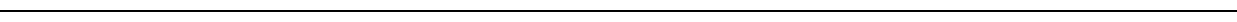
Fig. 2 Human MiPs engraft and are able to functionally regenerate dystrophic muscles. a , b Four weeks after delivery, immunostaining shows that fi broblast- and MAB-MiPs engraft and express hDYS to a similar extent in the heart, but differently in the hindlimb muscles ( gastrocnemius ). After AP20187 administration and at the end of treatment (eight weeks post delivery), the trend remains in vehicle-treated mice, whereas GFP and hDYS signals are ablated from AP20187-treated mice. Scale bars, ∼ 100 μ m; insets, 20× magni fi cation of indicated fi eld. c Tetanic force of EDL muscles and treadmill assay showed that skeletal muscle performance was increased in fi broblast-MiP-treated vs untreated mice, and increased in MAB-MiP- vs fi broblast-MiP-treated mice. Also, the functional gain was lost after AP20187 injection. d Functional assessment of the heart, by means of fractional shortening quantitation, shows comparable amelioration in both MiP-treated cohorts, but not after induced MiP death. Furthermore, CK serum levels followed a trend similar to functional assessment of the skeletal muscles. Data points depict the average value of each animal. In e , f : * P < 0.05 vs sham; ** P < 0.05 vs sham and fi broblast-MiPs; § P < 0.05 vs own vehicle-control; Kruskal – Wallis and Mann – Whitney U test; n = 6/cohort before AP20187, n = 3/cohort at end-point. e Bungarotoxin-based staining of NMJs throughout whole EDL and soleus muscles ( n = 3/cohort) reveals that dystrophic mice (sham) present highly fragmented NMJs, while MiP-engrafted fi bers present NMJs with a morphology siilar to WT fi bers. Quantitation of non-, mildly and highly fragmented NMJs displays that only MiP-engrafted, but not non-engrafted, fi bers in treated animals have a WT-like quantitative pattern ( n = 3/cohort). Depicted are average ± st. dev bars. f-, fi broblast-derived. f Masson ’ s trichromic staining of hindlimb ( quadriceps ) muscles of recipient mice. Scale bar ∼ 50 µ m. Blue scars denote fi brosis, while myocytes are stained in red. Fibrosis is signi fi cantly reduced in MAB-MiPs recepient muscles at 4 weeks p.i., while the difference is ablated after AP20187 amministration at 8 weeks